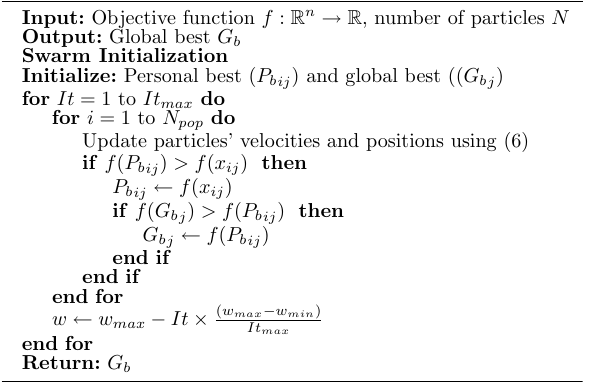
Algorithm 1 PSO-TPME